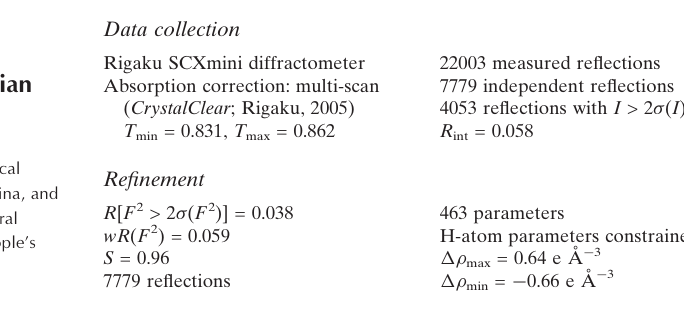
Rigaku SCXmini diffractometer Absorption correction: multi-scan